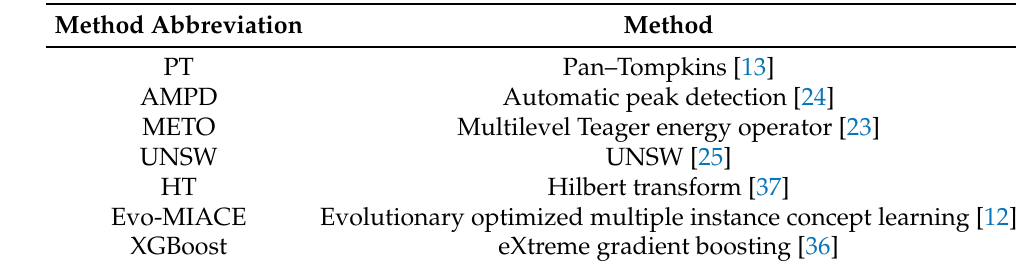
Table 3. The comparison algorithms of this paper.